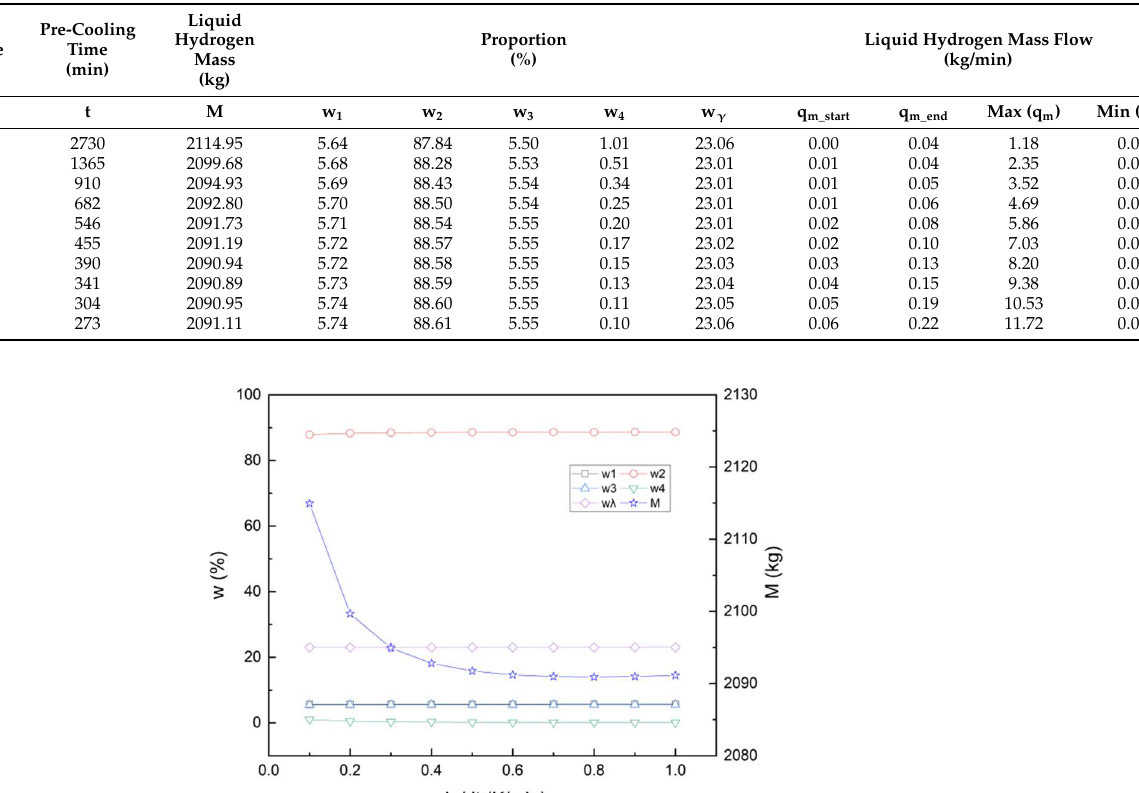
Table 2. Pre-cooling process parameters at different cooling rates.